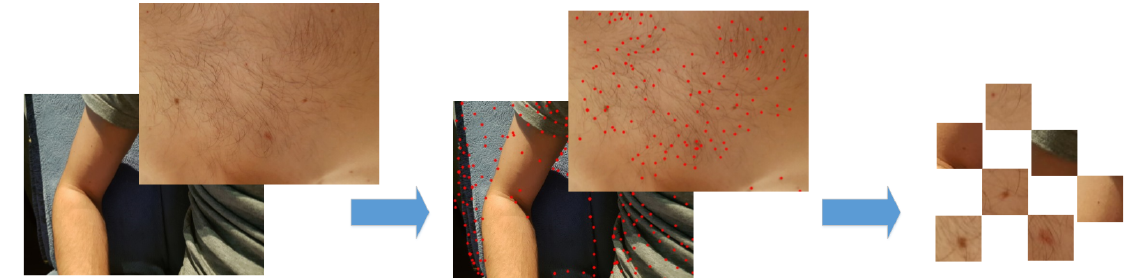
Figure 7. The process of creating clustered image files with nevi for classification. The original image is processed by the use of SIFT method which shows potential locations of key-points. After clusters are composed, and each of them is evaluated and cropped to show the suspicious nevus in the best possible way to make the evaluation the next phase more